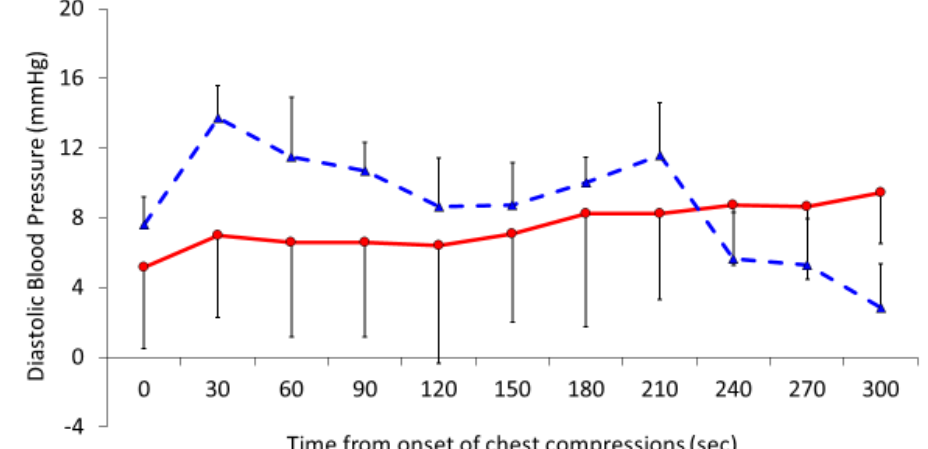
Figure 4. Interrupted line represents 21% and continuous line 100% oxygen. Data presented as average and standard deviation. ( A ) Systolic blood pressure and ( B ) diastolic blood pressure in mm Hg during CC.